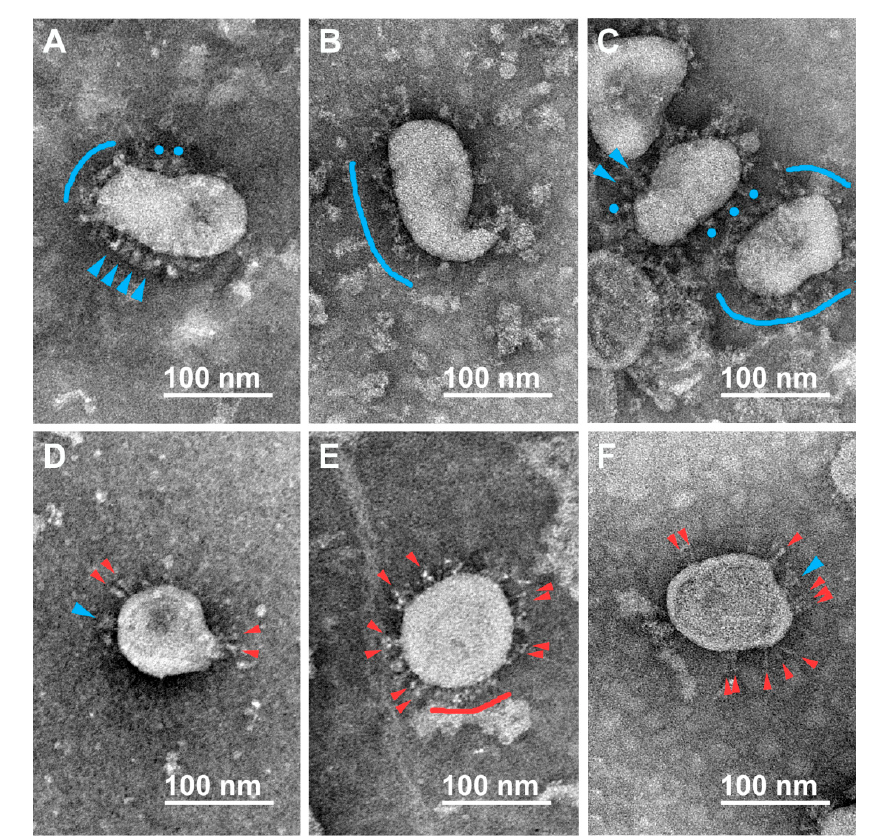
Figure 2. Electron microscopy images of SARS-CoV-2 virions subjected to inactivation with BPL (1:2000, 36 h, 4–8 °C). Single spikes of different morphologies are distinguishable on the virions’ surfaces. Flails (blue arrowheads), rounded flails (blue circles), and flail coats (blue arches) supposedly correspond to the pre-fusion conformation of S-trimers ( A – C ), while needles (red arrowheads) and their coats (red arches) supposedly correspond to the post-fusion conformation of S-trimers ( D – F ).